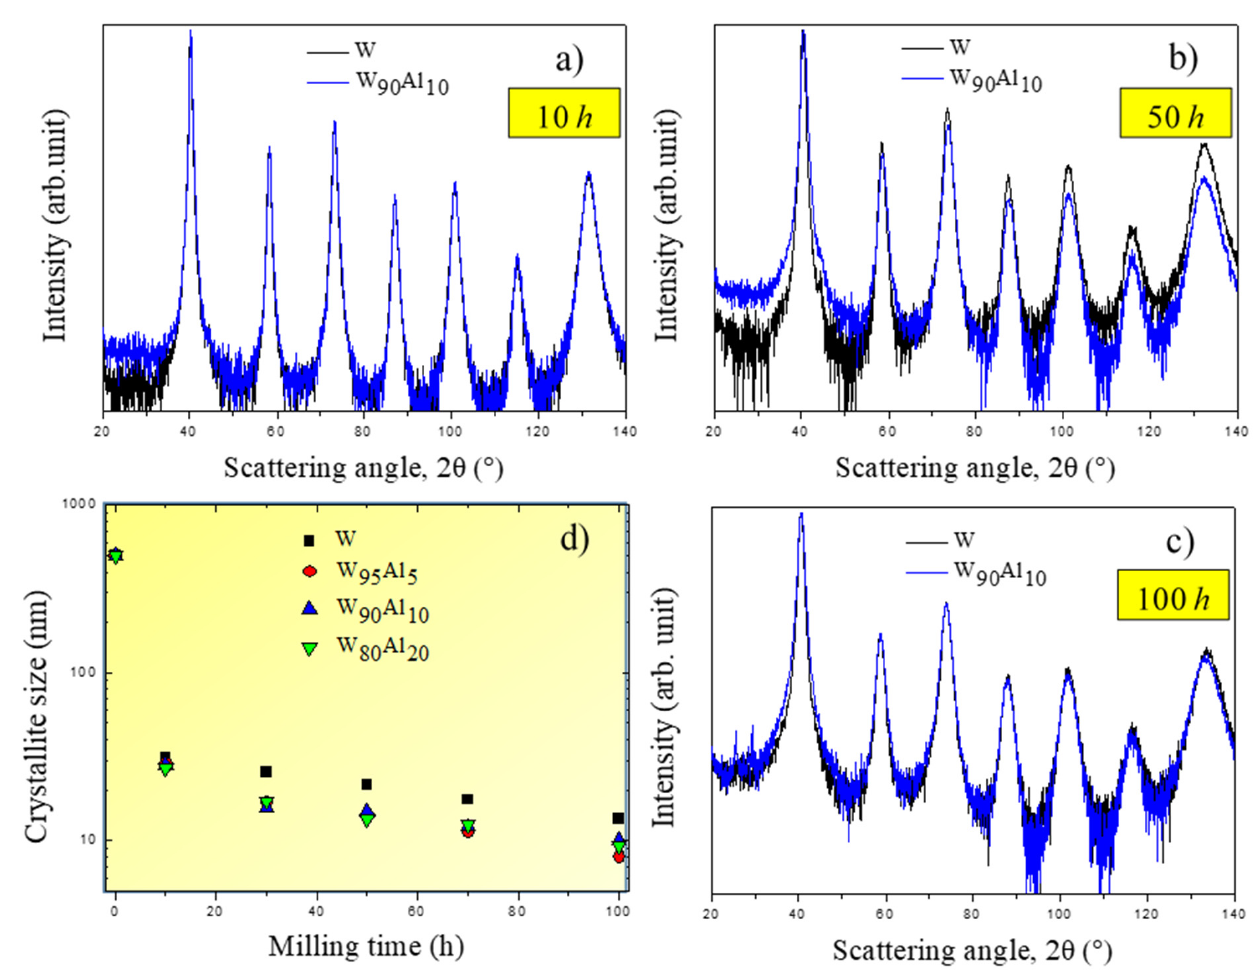
Figure 4. XRD pattern of mechanically treated W 90 Al 10 mixtures for different ball milling time: ( a ) 10 h; ( b ) 50 h; ( c )100 h. ( d ) Crystallite size as a function of ball milling time.